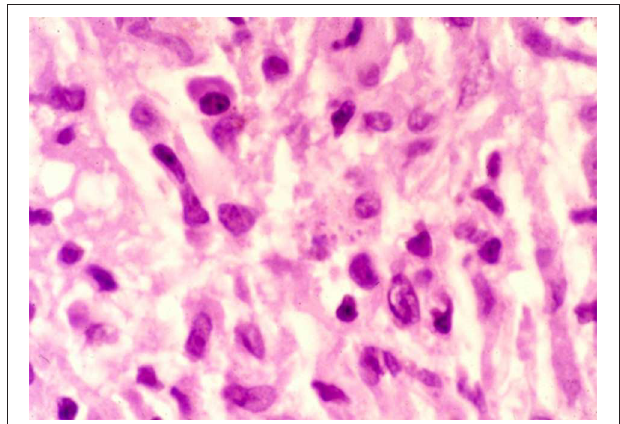
FIGURE 1 | Typical papular rash in a patient from Sudan.